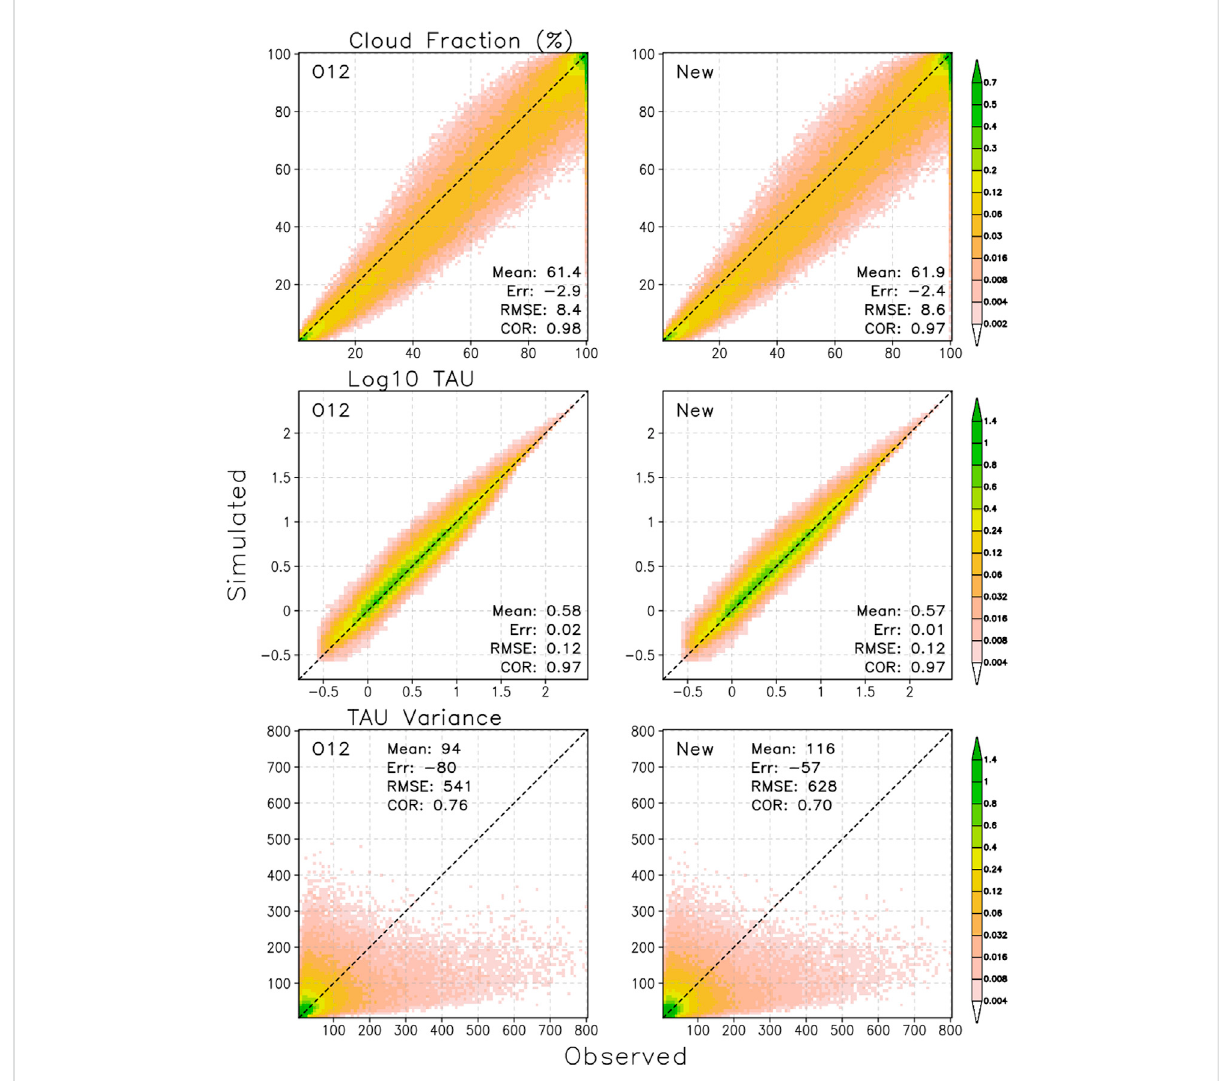
FIGURE 9 Comparison of the performance of the O12 (panels is left column) and the present (panels in right column) decorrelation length parameterization at the level of individual scenes simulated with the Raisanen subcolumn generator. Occurrence frequencies are shown for combinations of observed and simulated vertically projected scene cloud fraction CF (top row), the logarithm of vertically integrated optical depth log (TAU) (middle row), and the variance of the vertically integrated optical depth var (TAU) (bottom